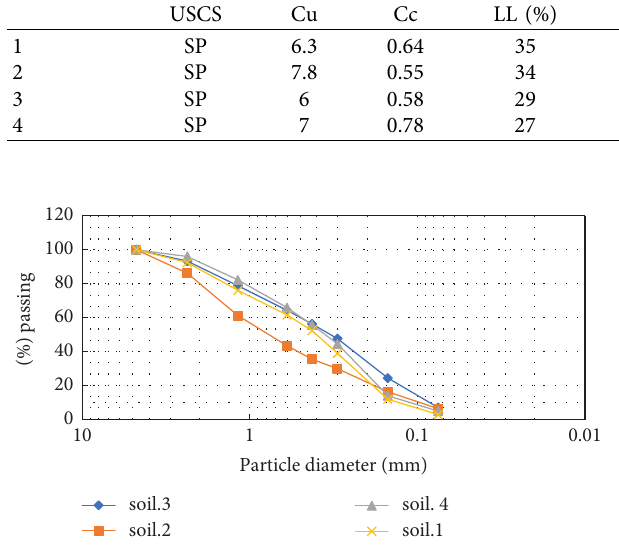
Figure 1: Te grain-size distribution curve of the soil samples corresponds to four types of soil.